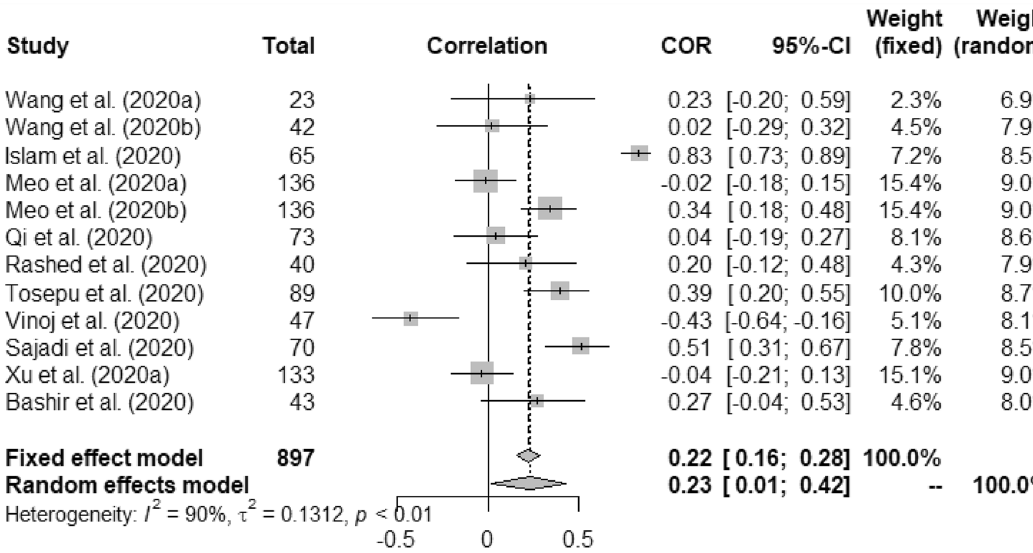
Figure 4. Forest plot of COVID-19 incidence with temperature.